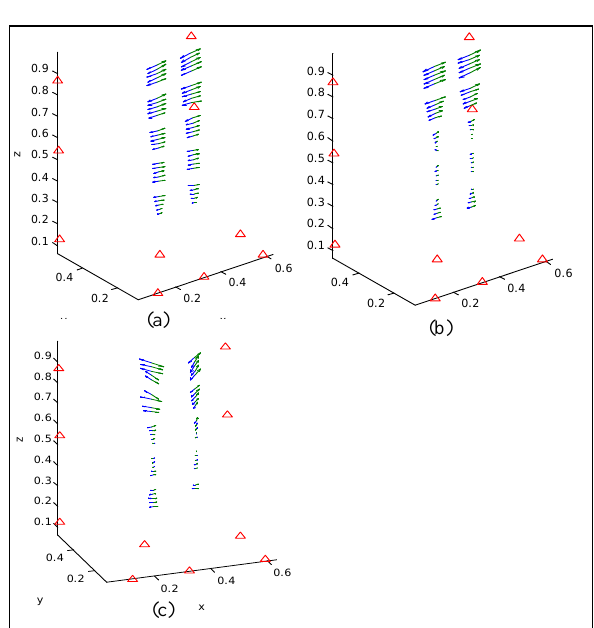
Direction of table motion